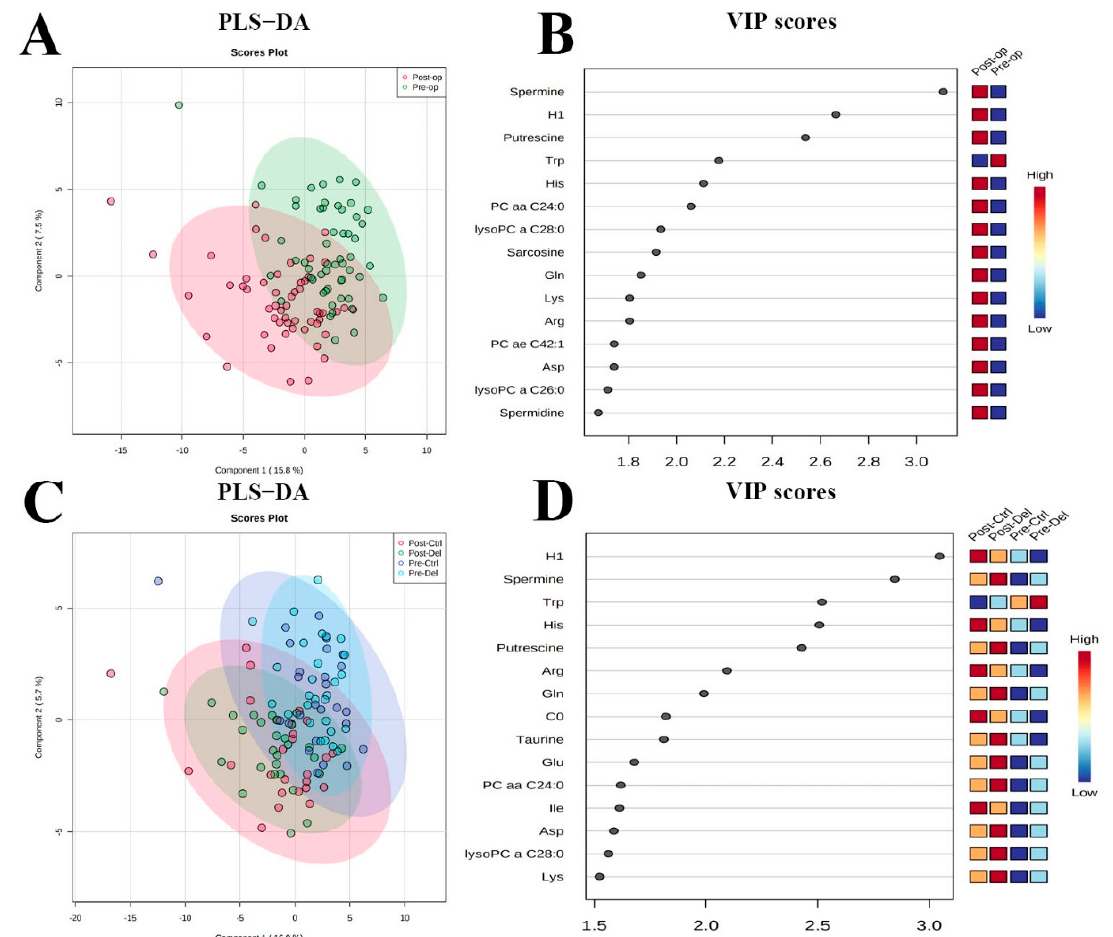
Figure 2. Multivariate modeling of metabolites by phase of surgery and delirium status. ( A ) Par- tial least squares discriminant analysis (PLS-DA) of preoperative and postoperative samples and ( B ) the resulting variable importance in projection (VIP) plot showing the 15 most influential me- tabolites responsible. ( C ) PLS-DA of control and delirium cases preoperatively and postoperatively and ( D ) resulting VIP showing the 15 most influential metabolites responsible. Pre-op: preoperative; Post-op: postoperative; Pre-ctrl: preoperative control; Pre-del: preoperative delirium; Post-ctrl: post- operative control; Post-del: postoperative delirium.